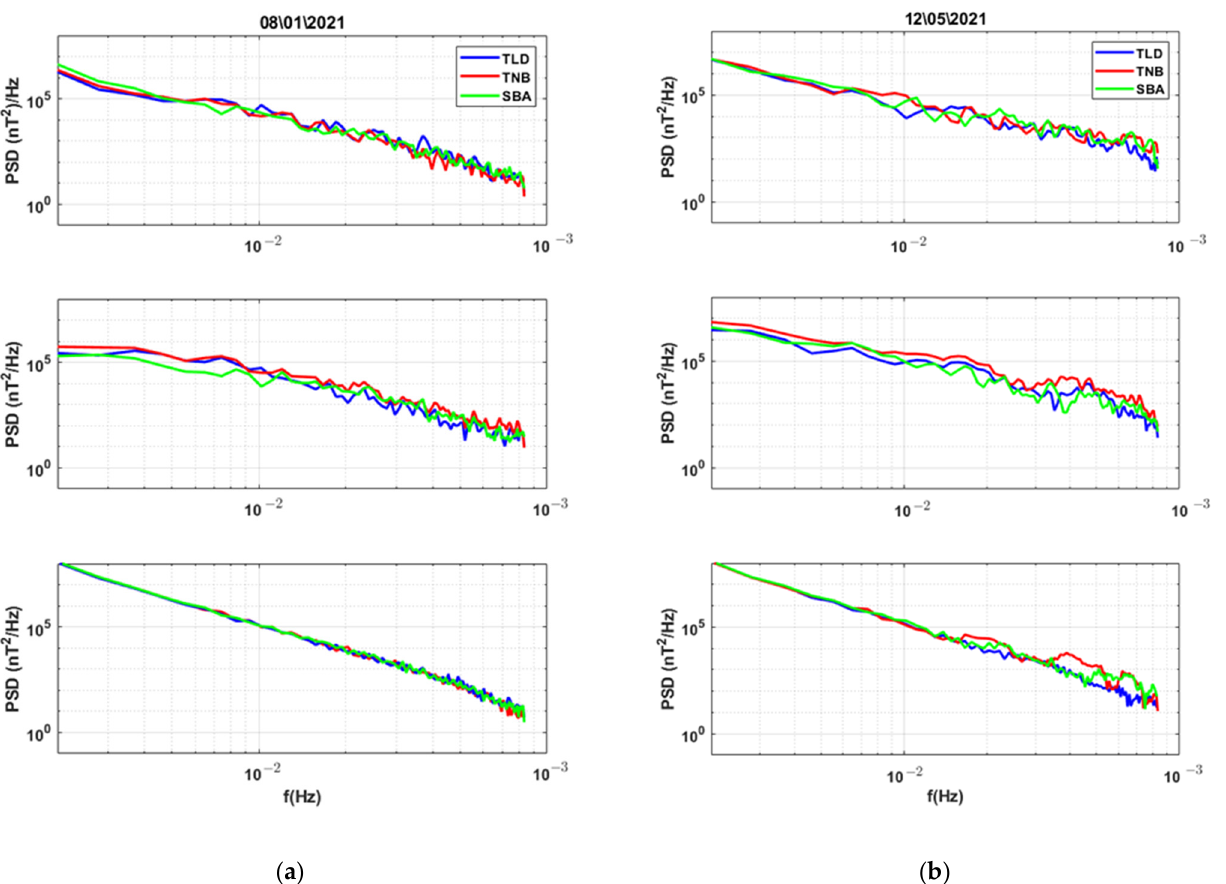
Figure 6. Power spectral density (PSD) of the three geomagnetic field components at the three stations for a quiet day ( a ) and for a disturbed day ( b ).